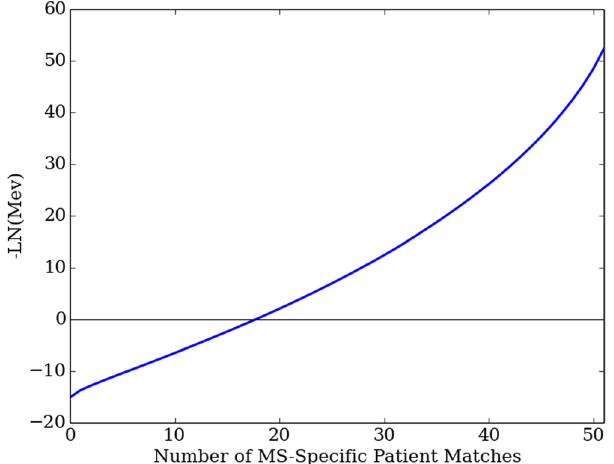
Figure 2. The -LN(Mev) is plotted for all possible DOM matches counts, ranging between zero and 51 MS patient matches. The plot is negative for match counts below a total of 20 patients, indicating that a DOM match to 20 patients or less may potentially occur at random. The plot is significantly greater than zero at 30 patient matches, which is our cutoff threshold for DOM